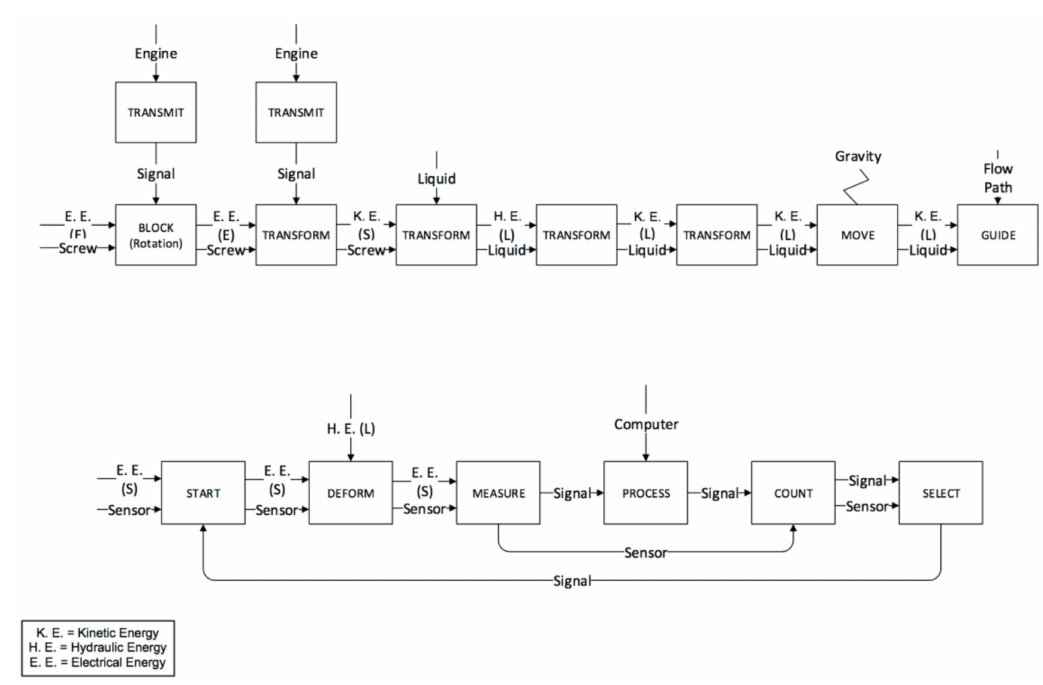
Figure 9. Feeding phase for the µ IM